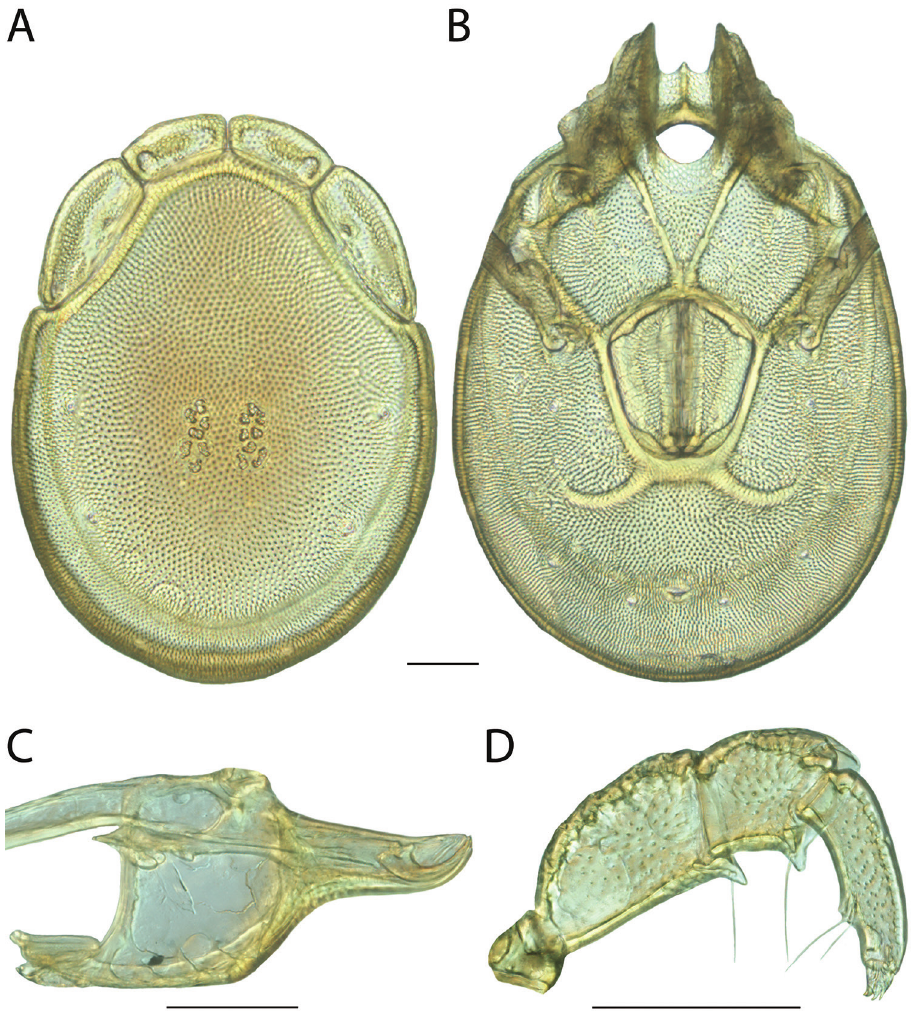
Figure 159. Torrenticola multiforma female: A dorsal plates B venter (legs removed) C subcapitulum D pedipalp (setae not accurately depicted). Scale = 100